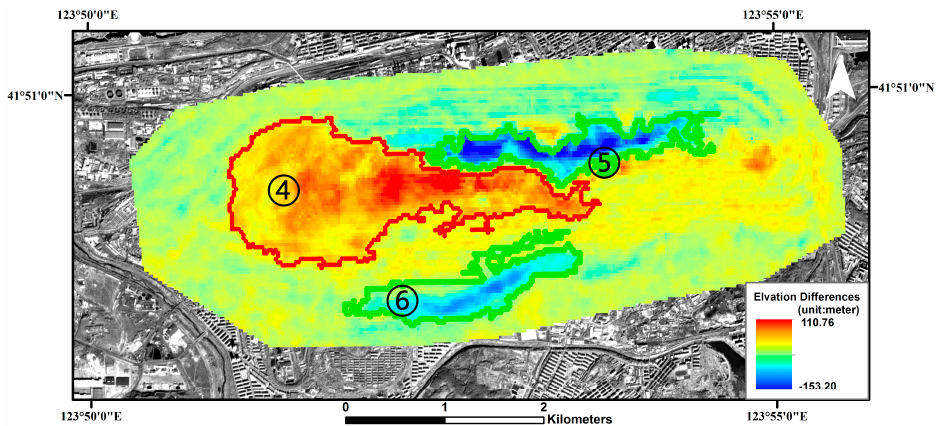
Figure 8. Deformation in the west open-pit mine and distribution of the Districts 4–6 with obvious elevations increase (red polygons) and elevations decrease (green polygons).